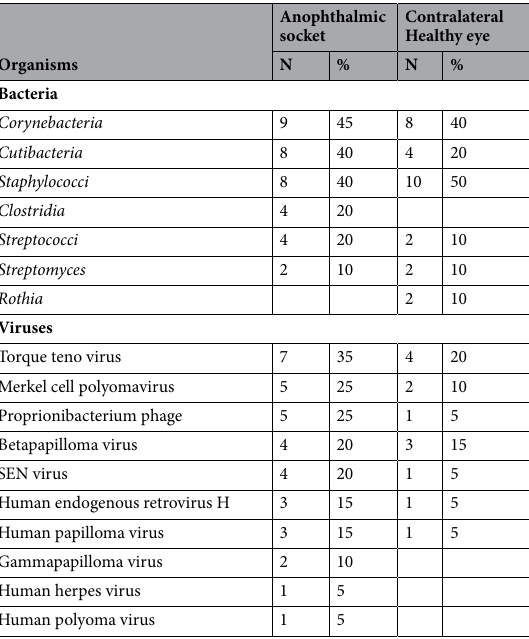
Table 5. BRiSK Detection of Bacteria and Viruses in Anophthalmic vs. Contralateral